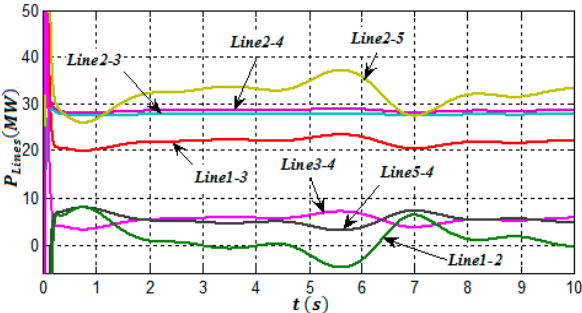
Figure 12. Active power flow on the lines with the wind farm connected at bus 5.